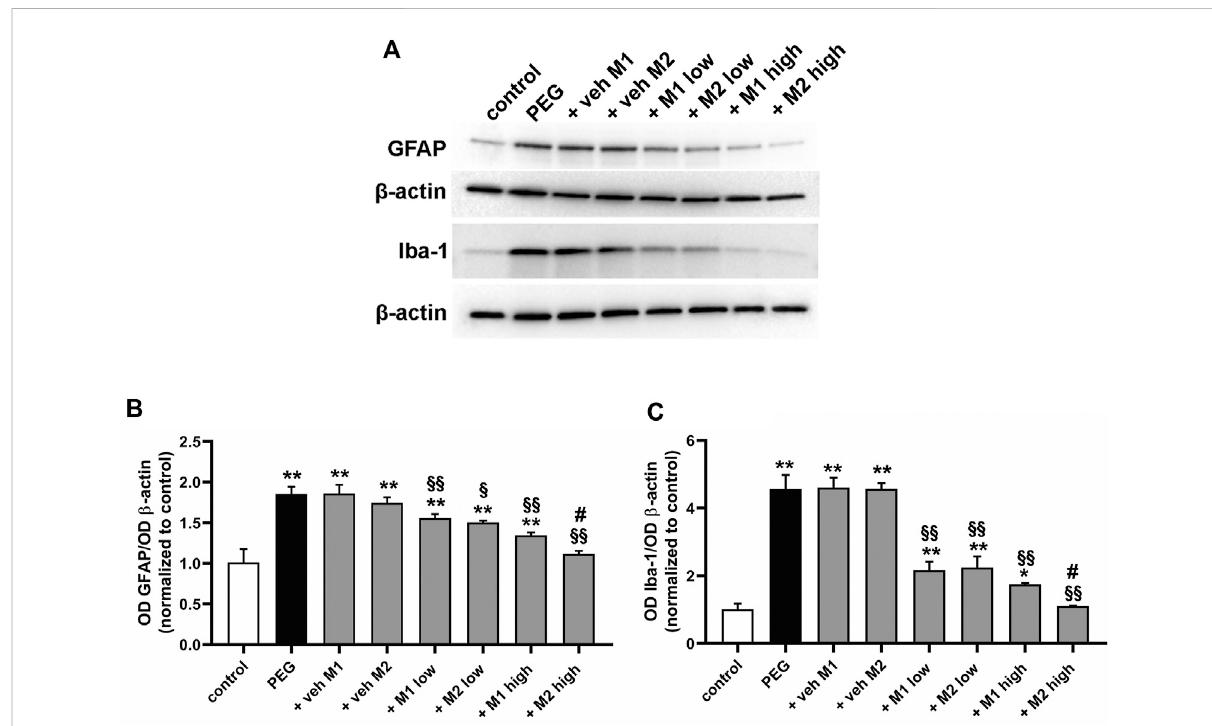
FIGURE 3 Effect ofM1 andM2 onMüller cellsgliosis and microglialreactivity. Representative Westernblots (A) and densitometricanalysis of GFAP (B) and Iba-1 (C) in controls, PEG-injected untreated, PEG-injected treated with M1or M2 vehicles, PEG-injected treated with low or high dose of M1as well aswithloworhigh-doseofM2. β -actinwasusedasloadingcontrol.Dataareplottedasmean±SEM.Differencesamonggroupswereassessedusing one-way ANOVA followed by Tukey ’ s multiple comparison post-hoc test (N = 6). * p < 0.01 and ** p < 0.001 vs. control; § p < 0.01 and §§ p < 0.001 vs. respective vehicle; # p < 0.05 vs. M1